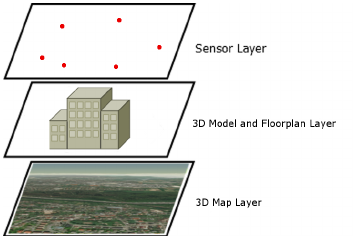
Figure 3. An illustration of a 3D visualization.